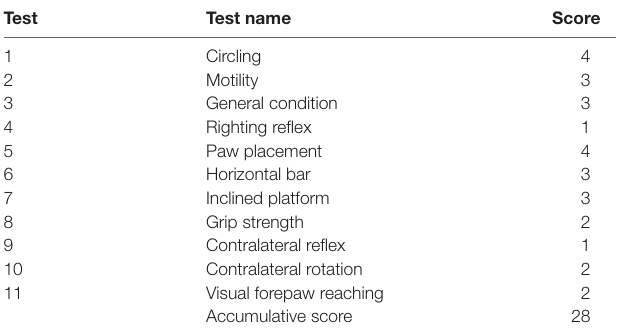
TABLE 3 | Twenty-eight-point composite neuro